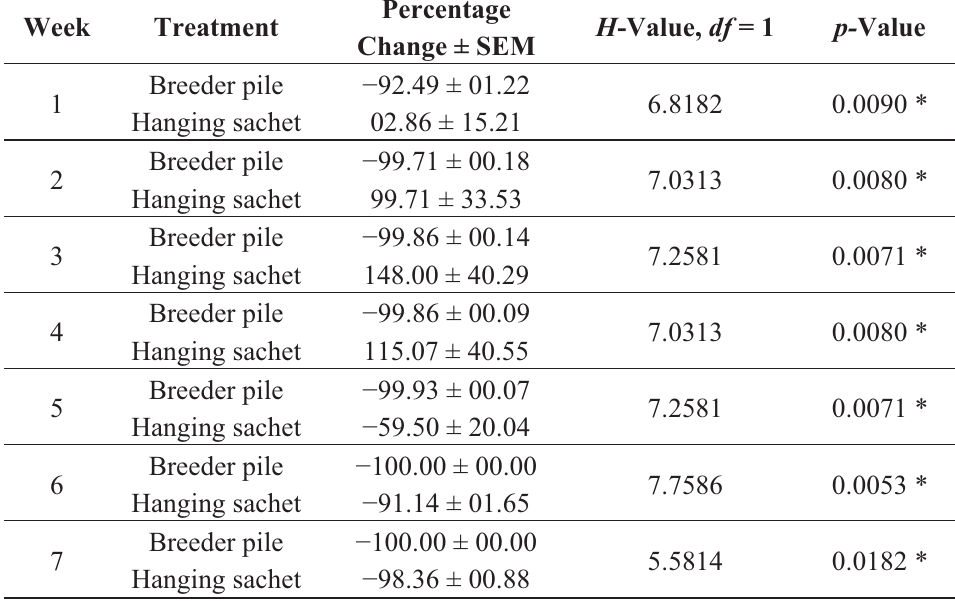
Table 1. Percentage change ± SEM of mean N. cucumeris densities in treatments after introduction in experiment 1, trial 1. * indicates significant differences between treatments (Kruskal-Wallis, α =